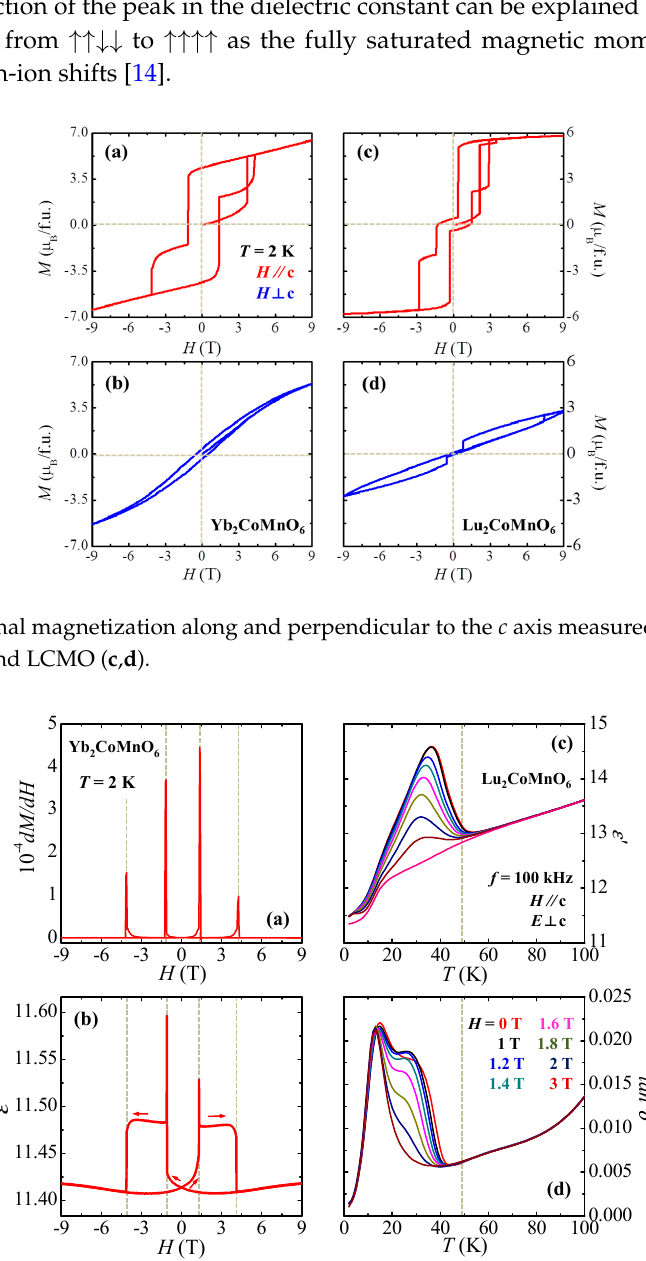
Figure 6. Derivative of isothermal magnetization at 2 K ( a ) and field dependence of dielectric constant ( ε′ ) at 2 K ( b ) for YCMO. Temperature dependence of dielectric constant ( ε′ ) and tangential loss ( tan δ ) perpendicular to the c axis under various magnetic fields ( H = 0, 1, 1.2, 1.4, 1.6, 1.8, 2 and 3 T) along the c axis for LCMO ( c , d ).